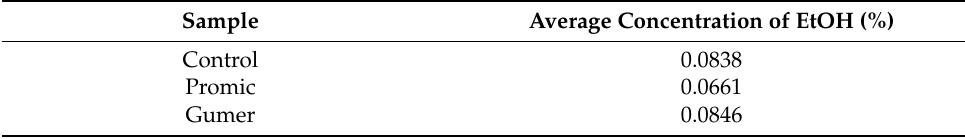
Table 1. Ethanol concentration detected in all fermented PP